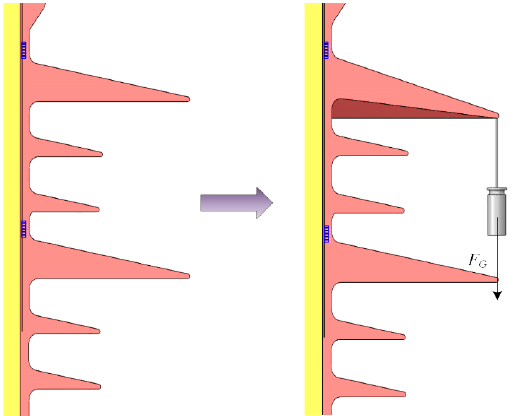
Figure 4. Hanging weights on a big shed for simulated loads of icicles [36].